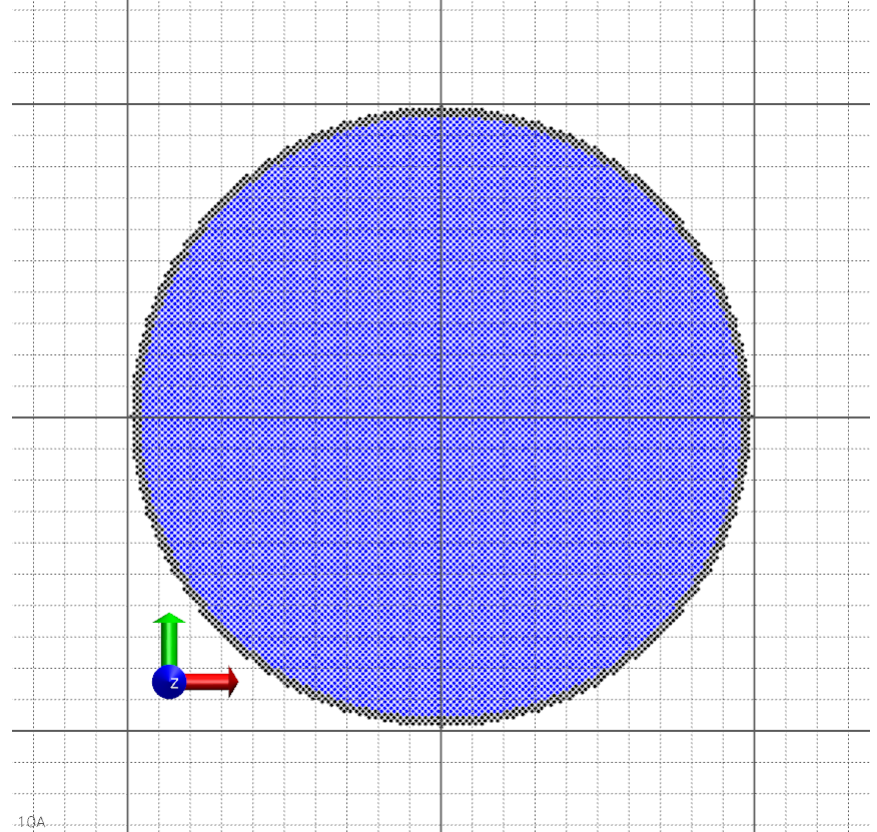
Figure 2. A snapshot of the solid underlay. Lennard-Jones 12-6 sites (blue) and purely repulsive sites with C 6 = 0 (black). The spacing of minor grid lines (dotted) is 1 nm. The square lattice of the particles is rotated by 45 ◦ with respect to the line grid. Graphics made by Visual Molecular Dynamics